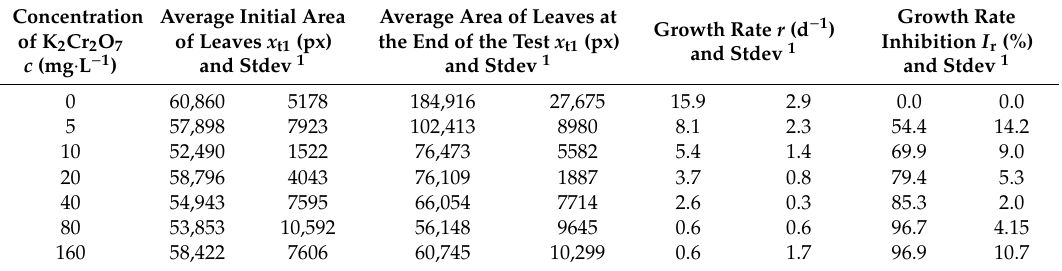
Table 3. Results of the test on the Lemna minor obtained from the leaves-occupied area measurement (image